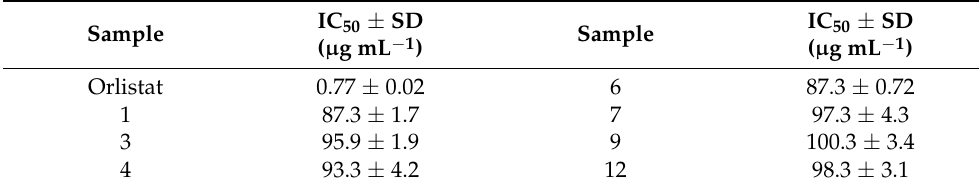
Table 4. IC50 ± SD values of samples in serial concentrations that showed lipase (porcine type II Sigma Aldrich) inhibition higher than